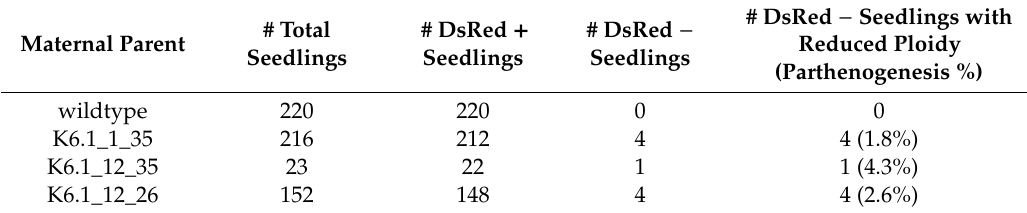
Table 5. Germination of progeny from the crosses between 4 x T2 plants of line RKD2gBB_6.1 and homozygous transgenic tobacco carrying a DsRed cassette. # Total # DsRed Maternal Parent Seedlings